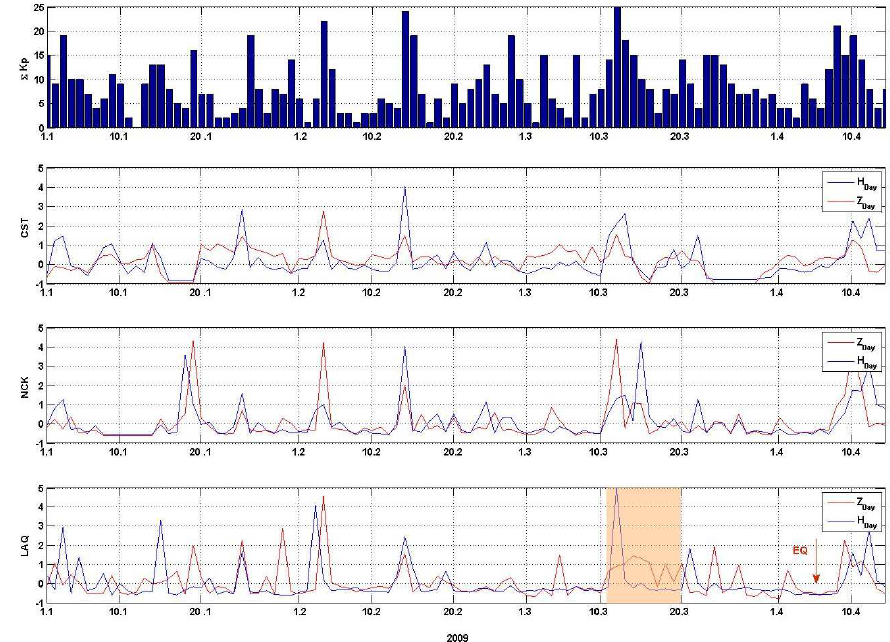
Figure 5 Fig. 5. P K p and standardized daily horizontal (blue) and vertical (red) PSD from 1 January 2009 to 14 April 2009 for CST, NCK, and LAQ station. Days in the colored shaded time period are probably influenced by ULF anomalies due to the impending seismic activity. The L’Aquila earthquake series main stroke is indicated with an arrow.